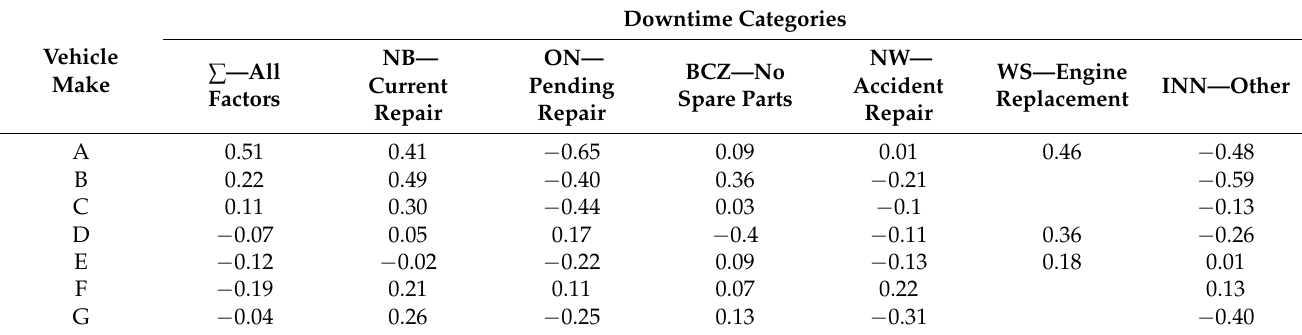
Table 5. Spearman’s rank correlation coefficient between categorized unavailability and the age of the